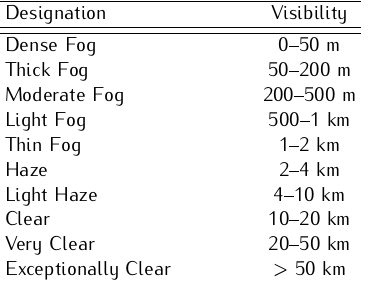
Table 3. Constants to be used in Equations (12) and (13). Table 4. International Visibility Code